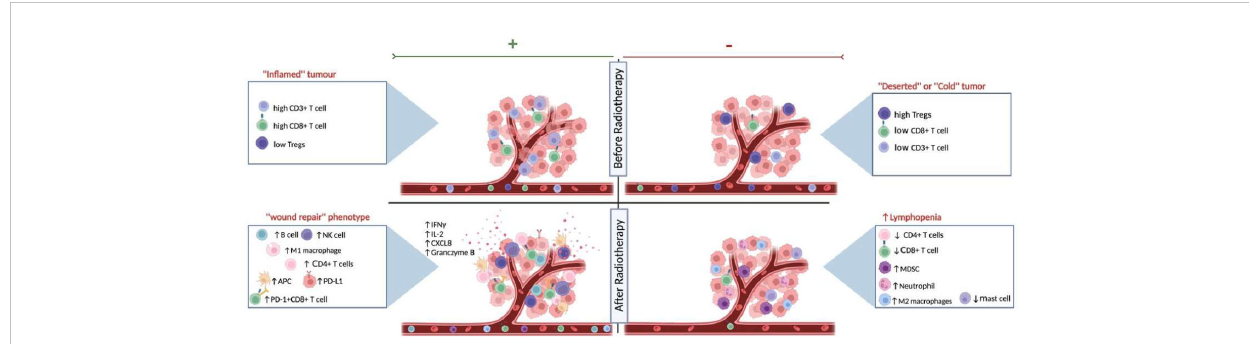
FIGURE 1 The effects of radiotherapy on the immune landscape. Schematic representation of the different states of systemic immune landscape and the tumor microenvironment before and after radiotherapy. As shown on the top left, the ‘‘ in fl amed immune ’’ phenotype responds better to RT, as exhibited by higher immunoscores (CD3+ and CD8+ T cell densities), while the ‘‘ deserted ’’ or ‘‘ cold ’’ tumors on the top right respond less well to radiation therapy. The effects of RT on the immune landscape are in fl uenced by the existing heterogeneous tumor microenvironment and the individual patient ’ s immune response. On the one hand, after RT, there might be a shift towards the wound healing signature (bottom left) and patients with this immune-hot phenotype have increased survival after treatment and might also be eligible for combination therapy with immunotherapy. Radiation can also cause a lymphopenic systemic and iTME landscape (bottom right), resulting in a worse prognosis. Created with